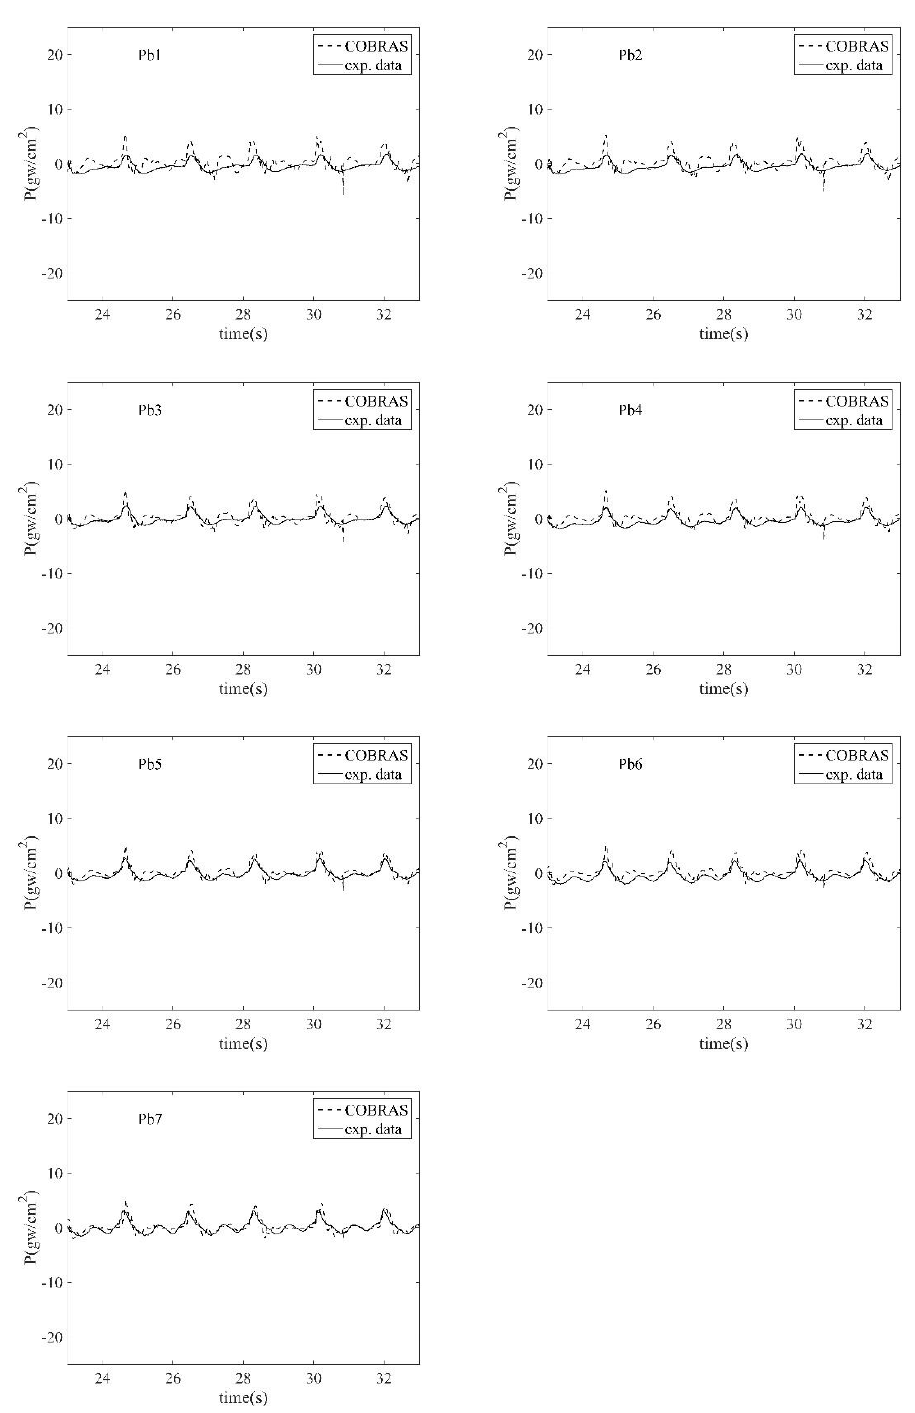
Figure 6. The comparison between numerical model and laboratory measurement for the time series of dynamic wave pressure on the landward face.